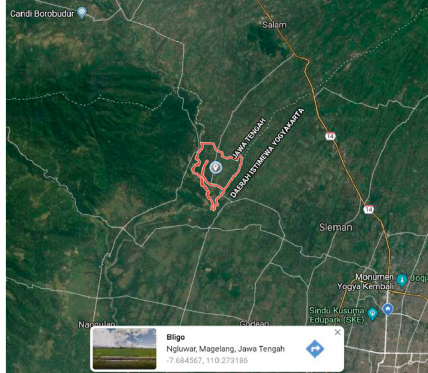
Figure 5: The geographical position of the location of this study.